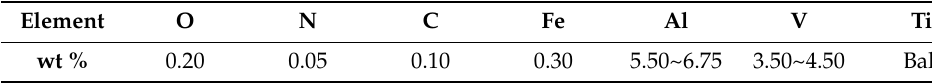
Table 1. Composition of the Ti6Al4V wire.